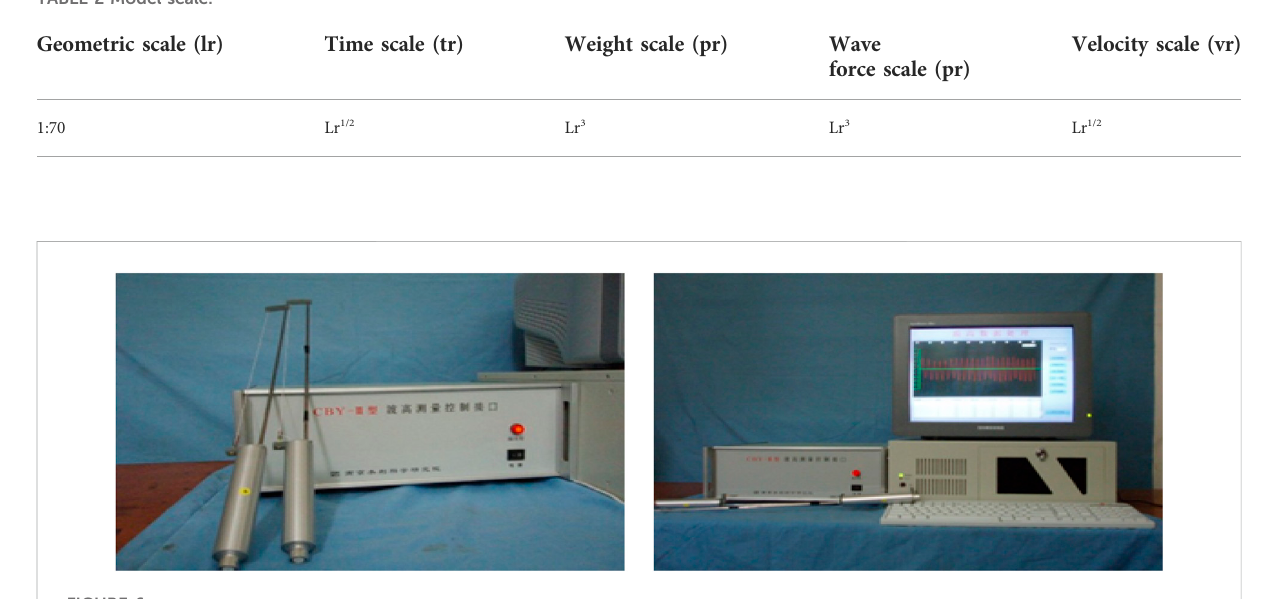
FIGURE 6 Type CBY- Ⅱ wave height measurement and control